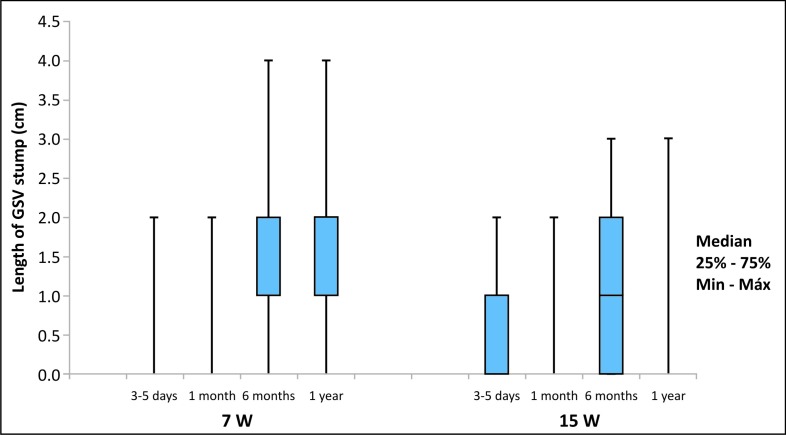
Graph showing results of comparison of the groups considering change in length of great saphenous vein (GSV) stump over 1 year follow-up.